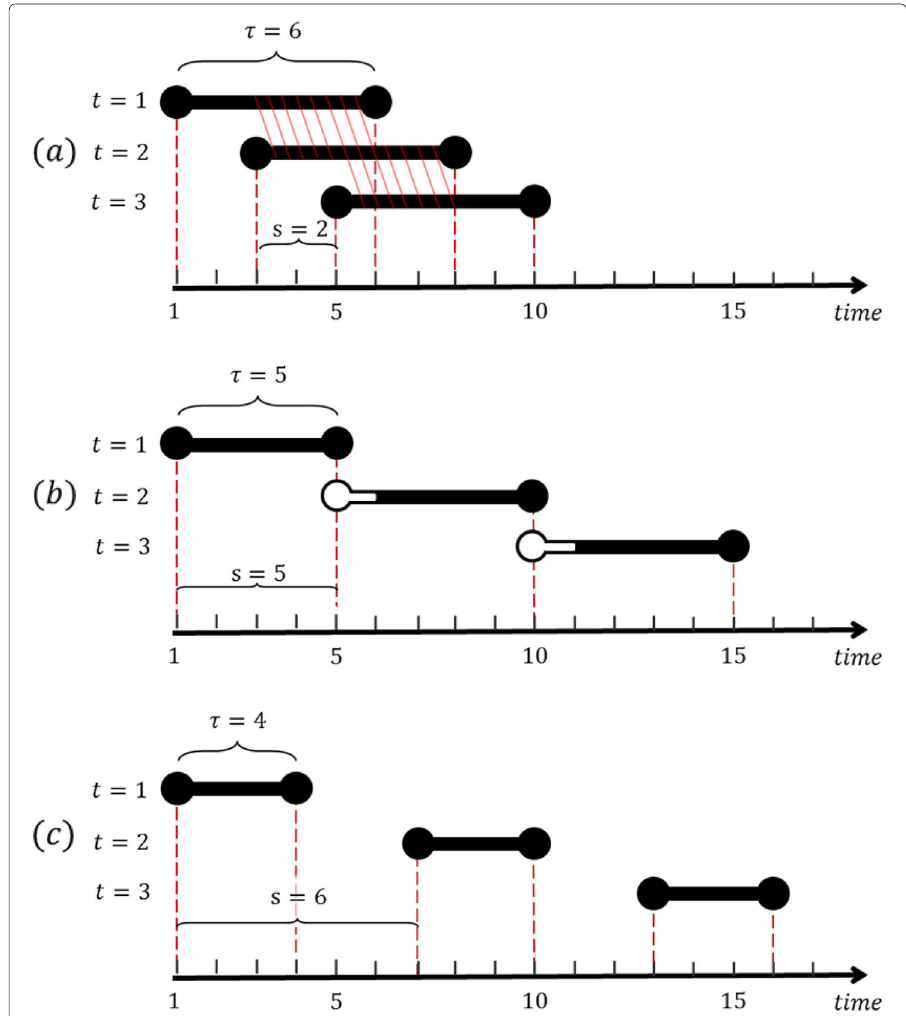
Fig. 3 Examples of time sliding window functions. a s < τ , data overlap exists. In ( b ), s = τ , and in ( c ) s > τ , no data overlap